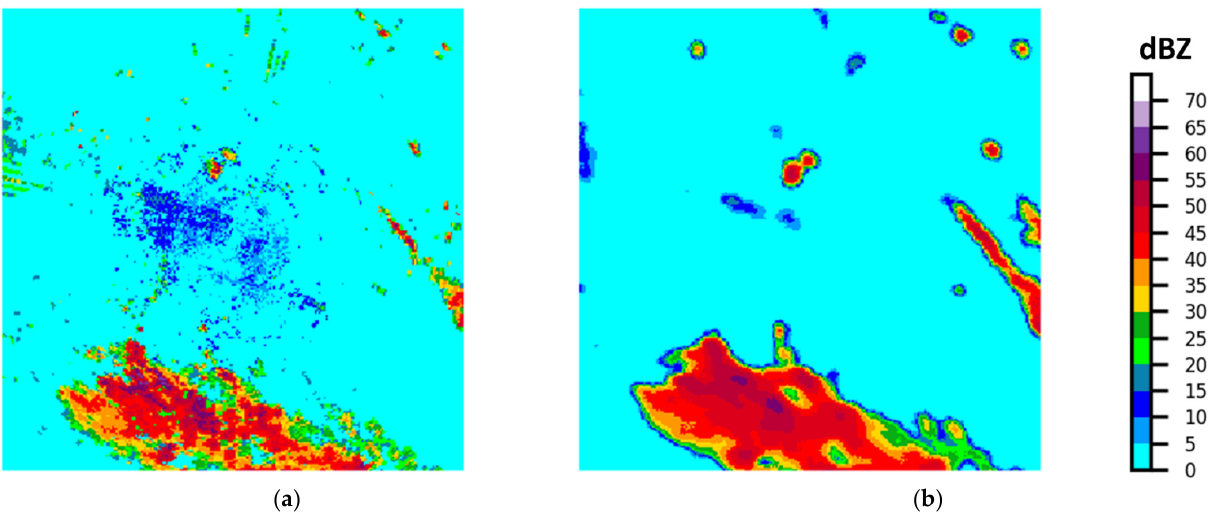
Figure 3. An example of TrajGRU prediction image (the first stage) and the corresponding ground truth image: ( a ) ground truth; ( b ) result by using the first stage prediction model.